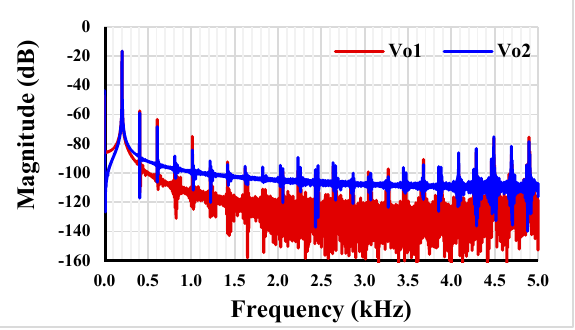
Figure 7. The FFT for V o 1 and V o 2 .